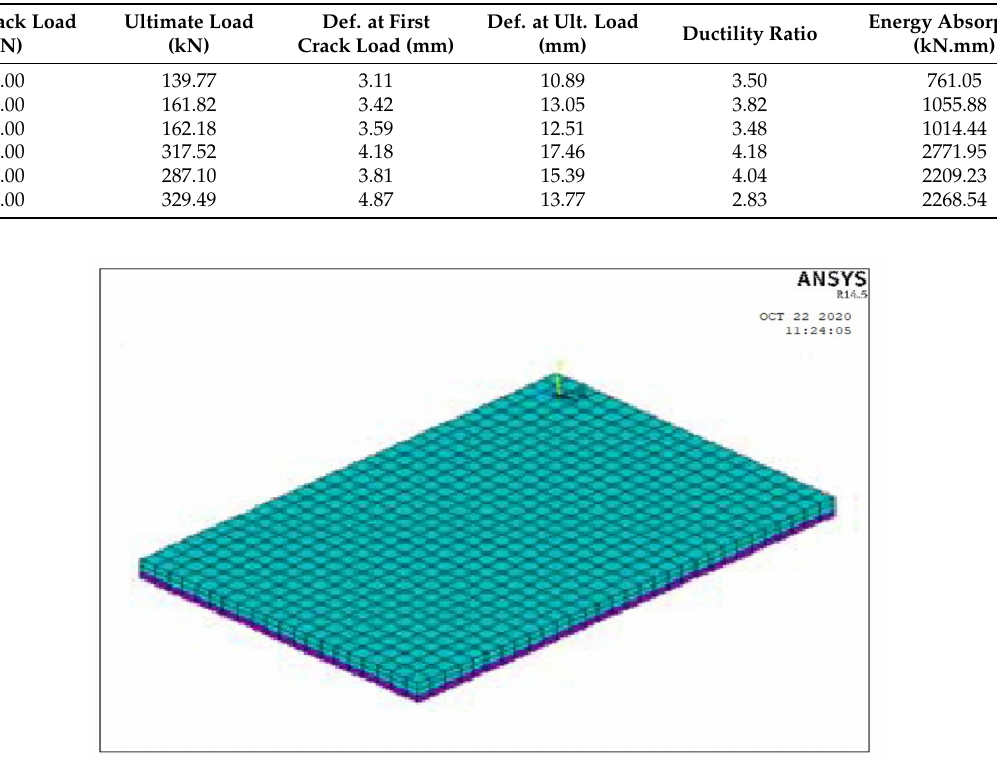
Table 12. Numerical results.